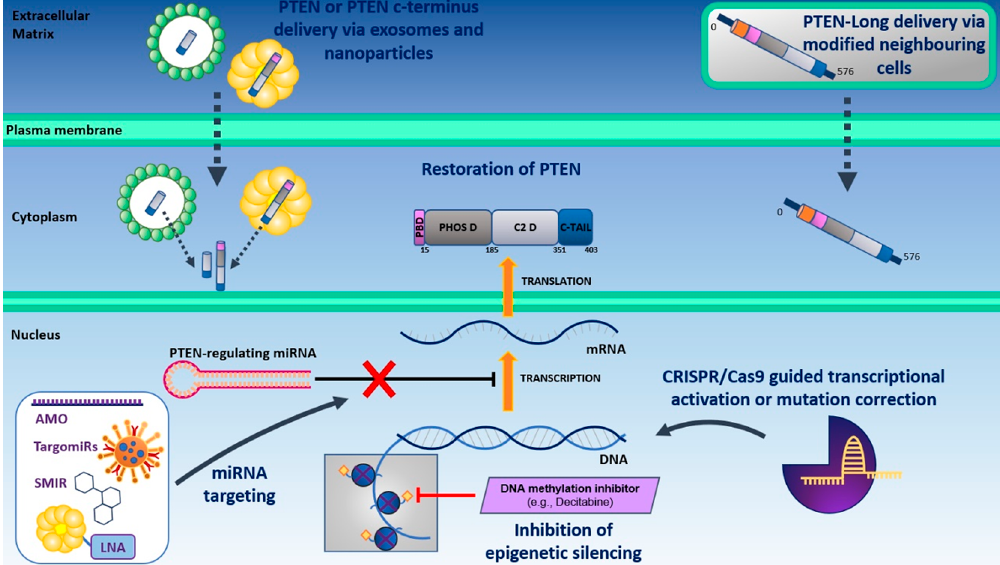
Figure 2. Experimental therapeutic approaches to restore PTEN functional dose. AMO, anti-miR oligonucleotide; C2 D, C2 domain; LNA, locked nucleic acid; Cas9, CRISPR associated protein 9; CRISPR, clustered regularly interspaced short palindromic repeat; miRNA, micro ribonucleic acid; PBD, PIP2-binding domain; Phos D, phosphatase domain; PTEN, phosphatase and tensin homologue deleted on chromosome 10; SMIR, small-molecule inhibitors of miRNA.